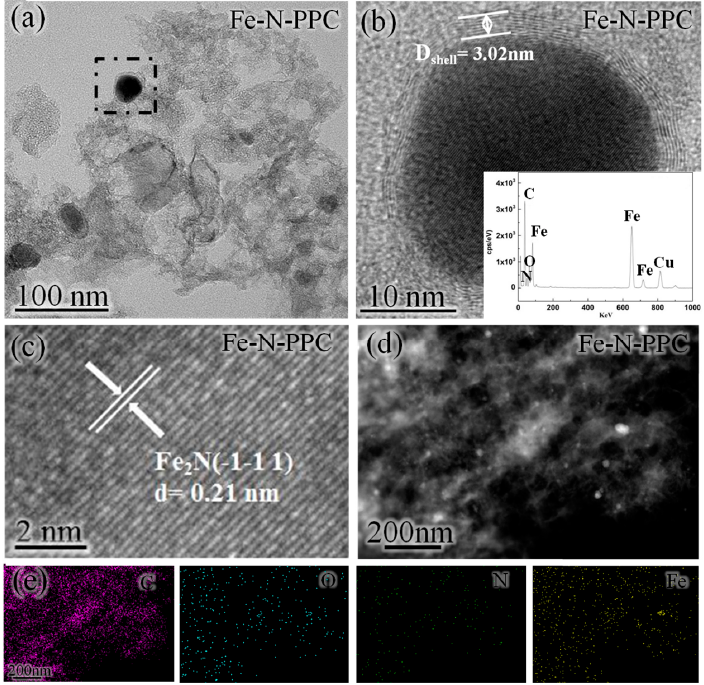
Figure 4. ( a ) Transmission electron microscopy (TEM) images; ( b , c ) energy dispersive X-ray spectroscopy (EDS) patterns and high resolution TEM (HRTEM) images of Fe-N-PPC; ( d ) high-angle annular dark-field scanning transmission electron microscopy (HAADF-STEM) image and ( e ) EDS elemental mapping images (C, O, N and Fe) of Fe-N-PPC. Table 3. BET surface area and Barrett–Joyner–Halenda (BJH) pore diameter of PPC and Fe-N-PPC. Sample